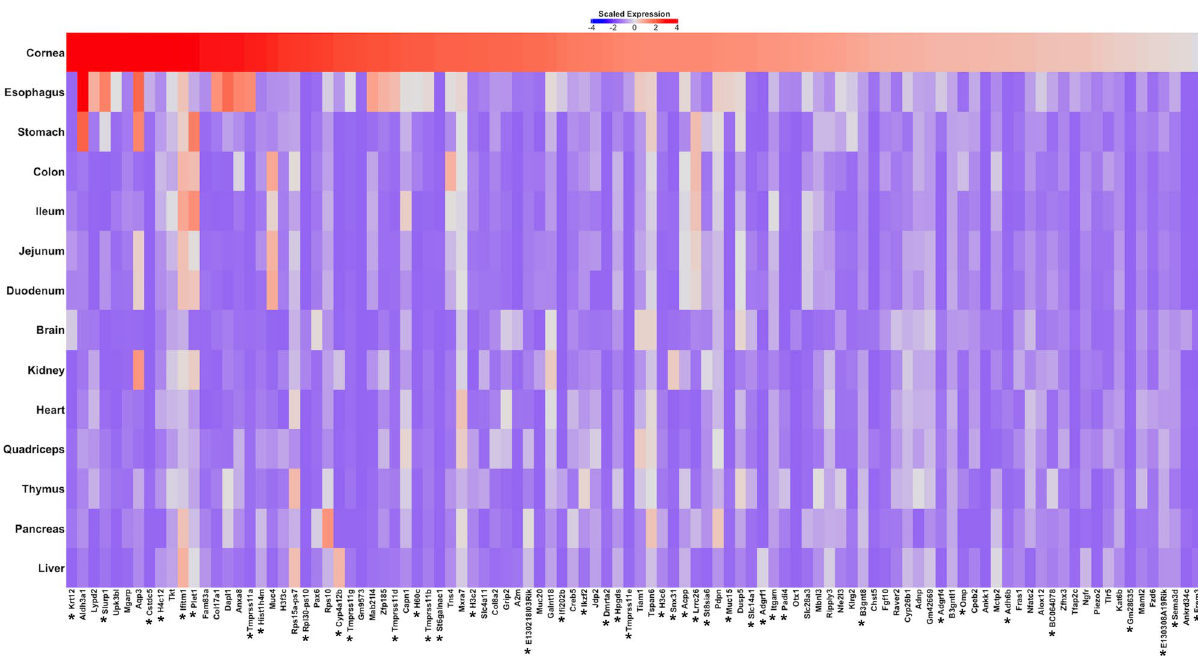
Figure 4. Mouse corneal gene expression. Gene expression data from RNAseq were processed to normalize and identify the 102 most abundant transcripts in mouse cornea. Expression of these genes was compared to expression levels of these genes in a panel of 13 mouse tissues (from tissue expression database, https:// www. omics di. org/ datas et/ array expre ss- repos itory/E- MTAB- 6081). Heat map illustrates relative expression level (see inset scale) in cornea and across indicated tissues. * indicates genes not identified as expressed in human CEC (on the basis of genes expressed in isolated human CEC 29,30 ) and thus likely expressed in corneal epithelial cells. One of these studies measured transcript abundance in 15 human CEC samples 30 . In this case, we considered genes as expressed in CEC if they were found in 10/15